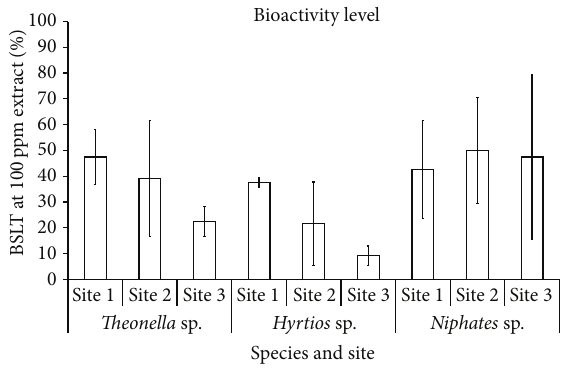
Figure 4: Bioactivity level by Brine Shrimp Lethality Test (BSLT) from each of the sponges at each sampling site in Hoga Island (mean ± SD, 𝑛 = 4 ).